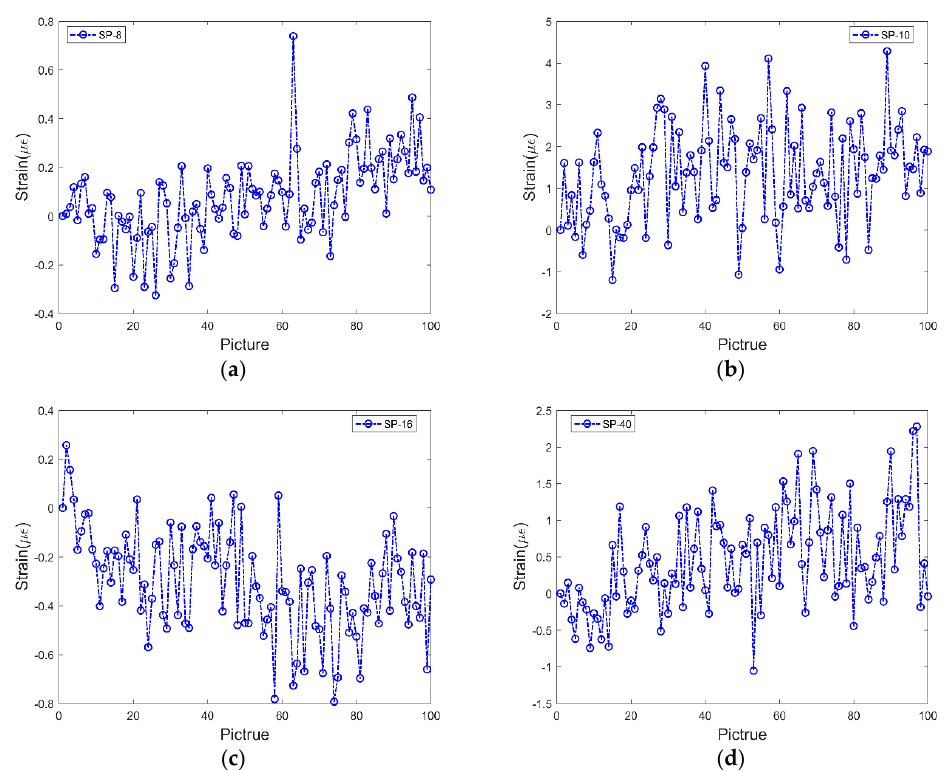
Figure 7. Strain data obtained using the two-marker point tracking method and smartphones with a resolution of ( a ) 8, ( b ) 10, ( c ) 16, and ( d ) 40 MP.